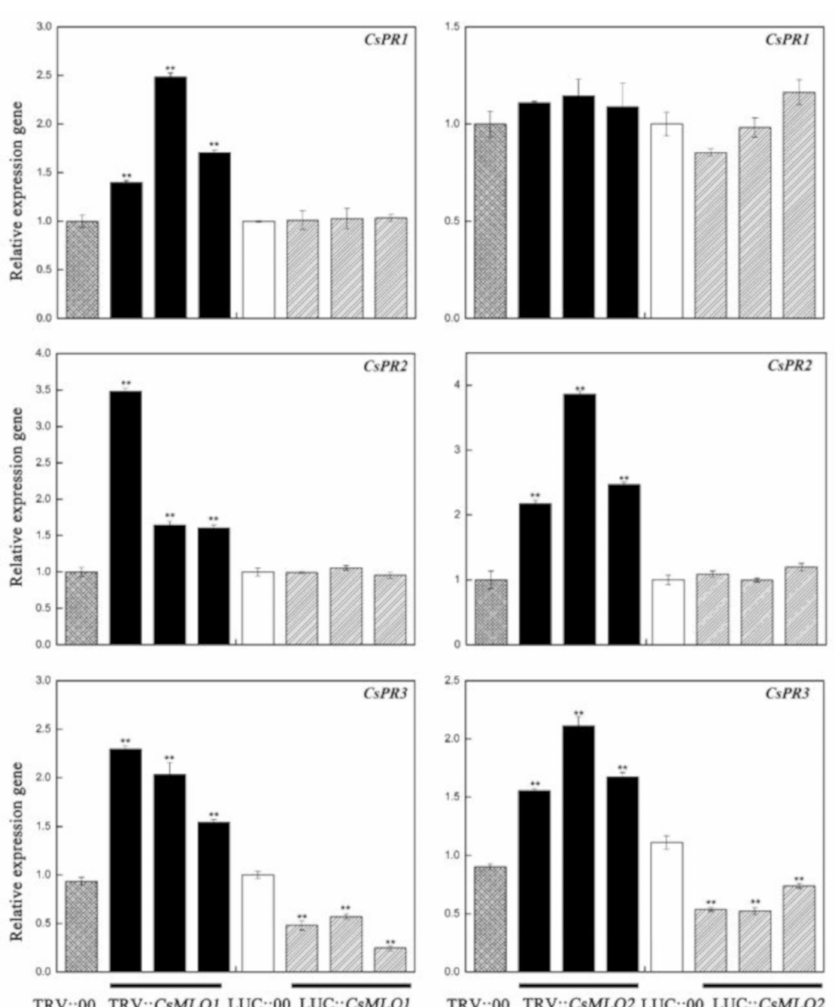
Figure 8. E ff ect of transgenic expressions of CsMLO1 and CsMLO2 in cucumber cotyledons on immunity induction. The di ff erent expression regulations of pathogenesis-related proteins ( CsPR1-1a , CsPR2 and CsPR3 ) are shown in transgenic plants. Data are means ± standard deviations from three independent experiments, and each column represents a sample containing three of cucumber cotyledons from di ff erent plants. Expression analysis of candidate genes using the 2 − ∆∆ Ct method. The asterisks indicated a significant di ff erence (Student’s t -test, *P < 0.05 or ** P <